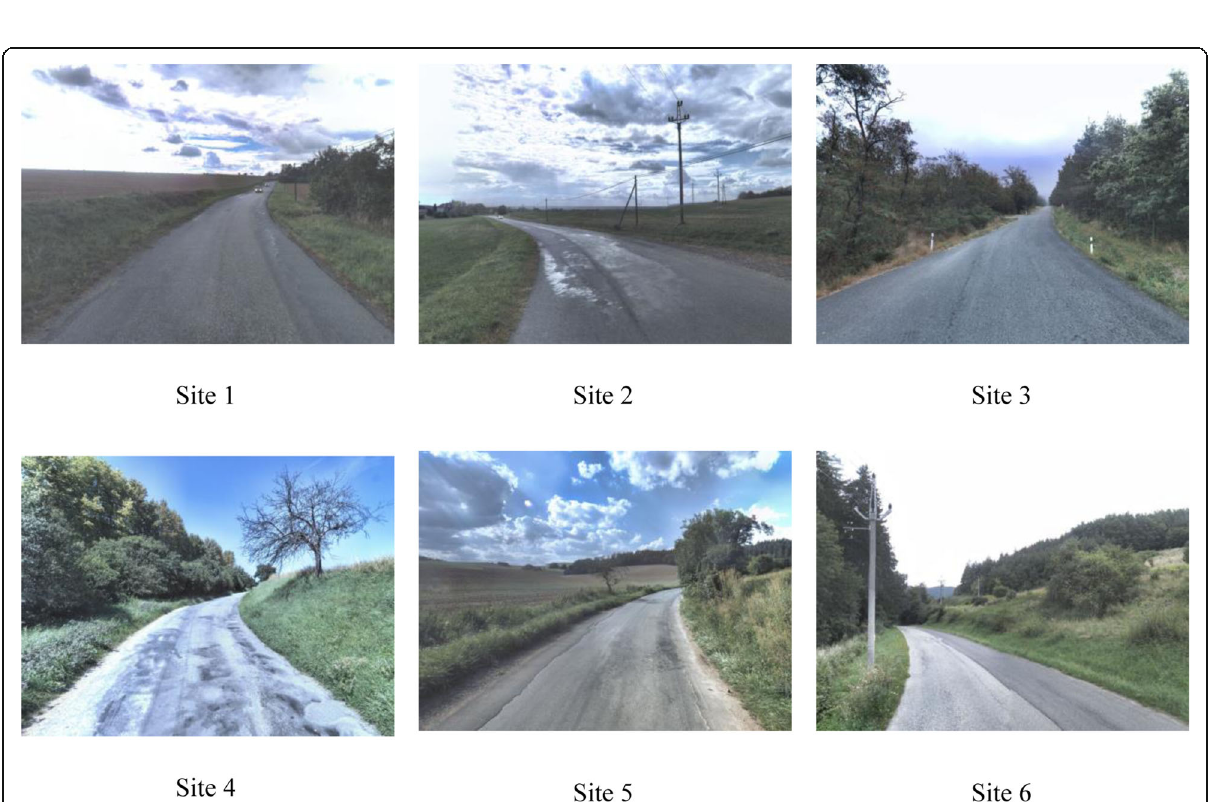
Fig. 4 Photographs of the studied sites (adapted from